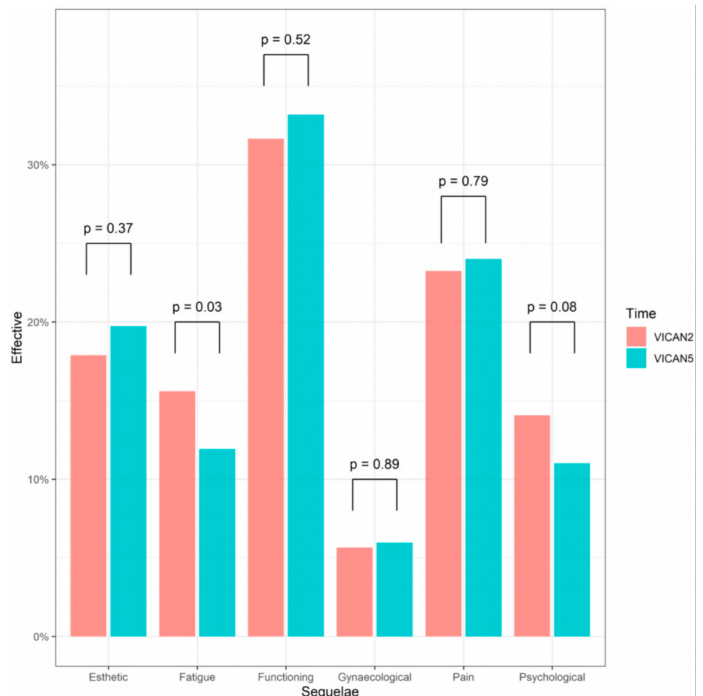
Figure 2. Evolution of sequelae between two years (VICAN2) and five years (VICAN5) after diagnosis of the six main sequelae ( n = 654).